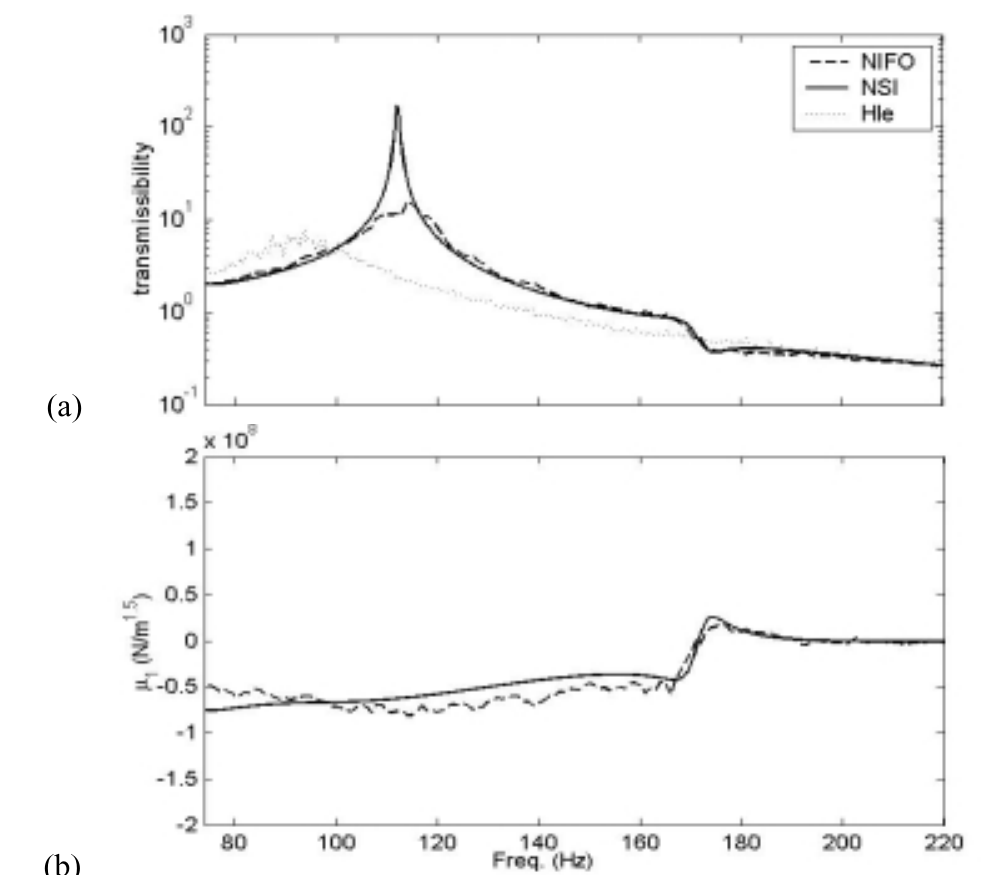
Fig. 7. Acceleration transmissibilility (a): NSI nominal linear estimate (solid line), NIFO nominal linear estimate (dashed line) and estimated by linear methods (Hle, dotted line, mean value between H 1 and H 2 procedures). Nonlinear coefficient (b): NSI estimate (solid line), NIFO estimate (dashed